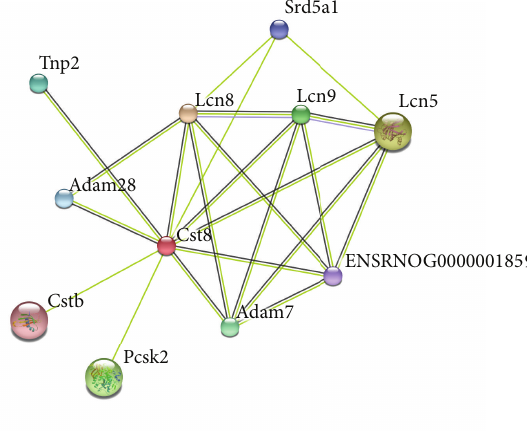
Figure 4: The PPI network of Cst8 gene.